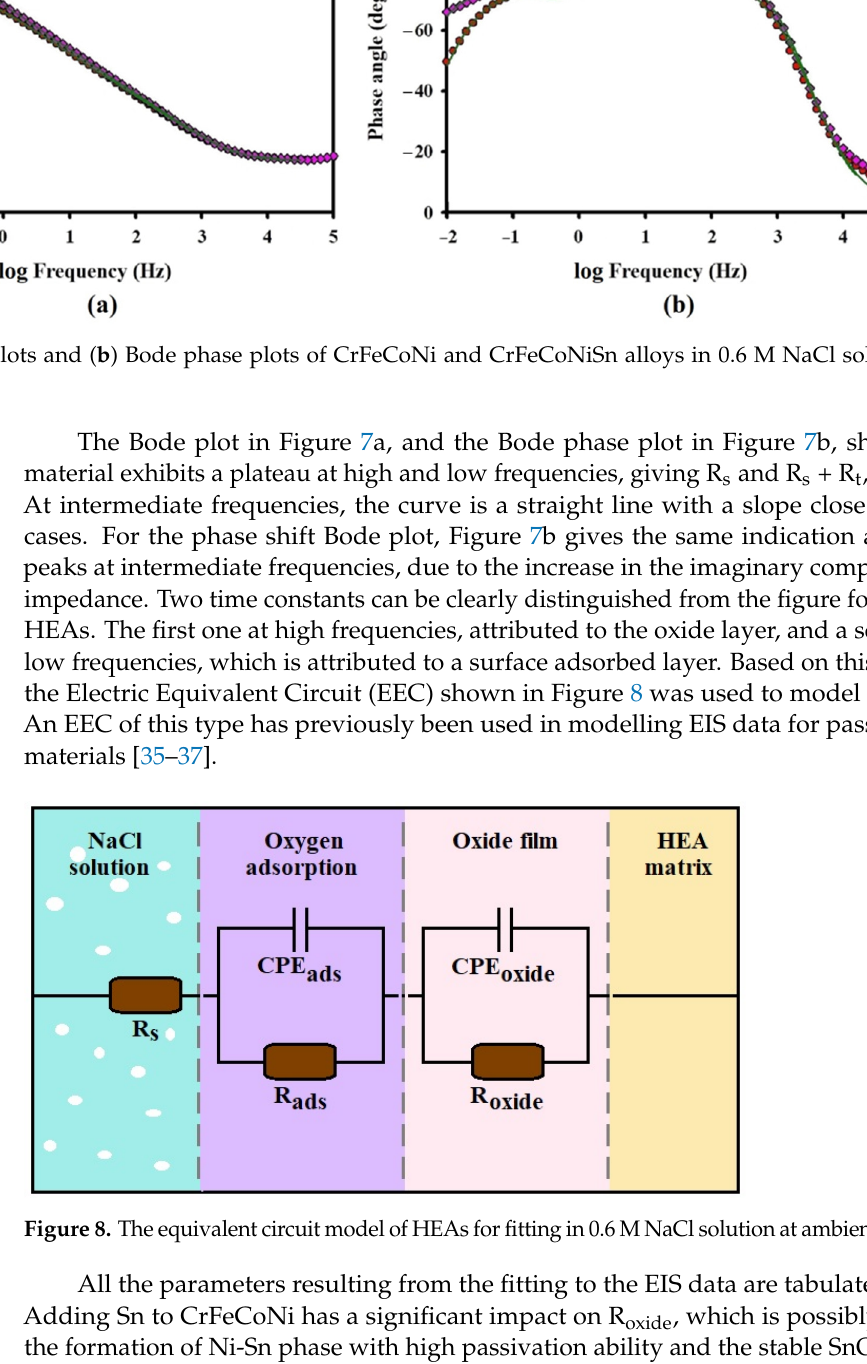
Table 4. EIS model parameters for CrFeCoNi and CrFeCoNiSn alloys in 0.6 M NaCl solution at ambient temperature. HEA System